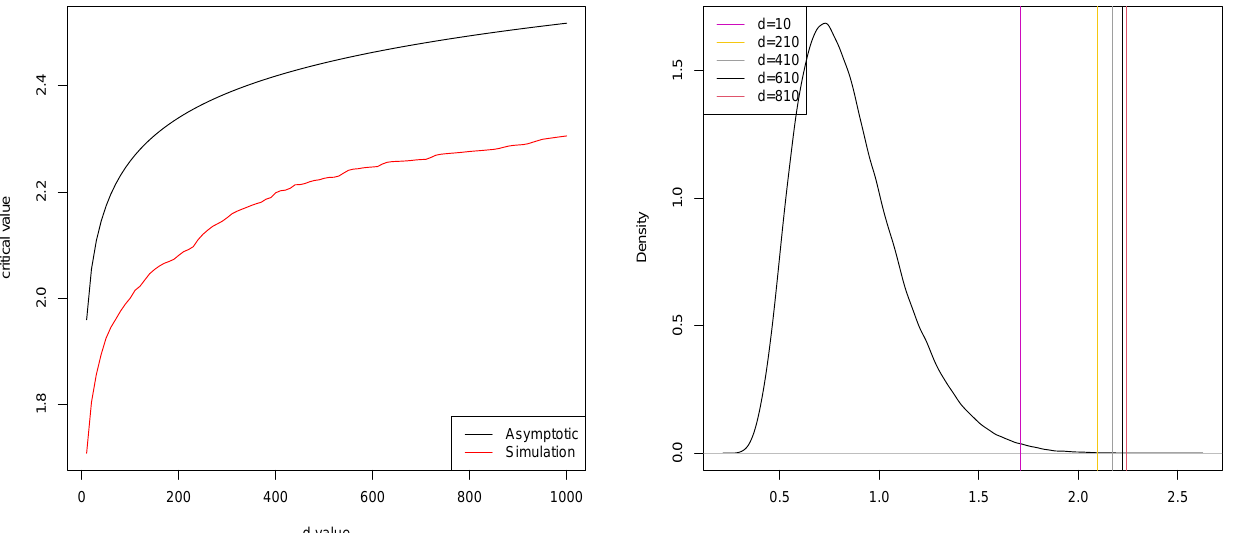
Figure 2. Comparison of the critical values in (20) and (25) with α = 0.05 and the density function of T n ,1 ( d )